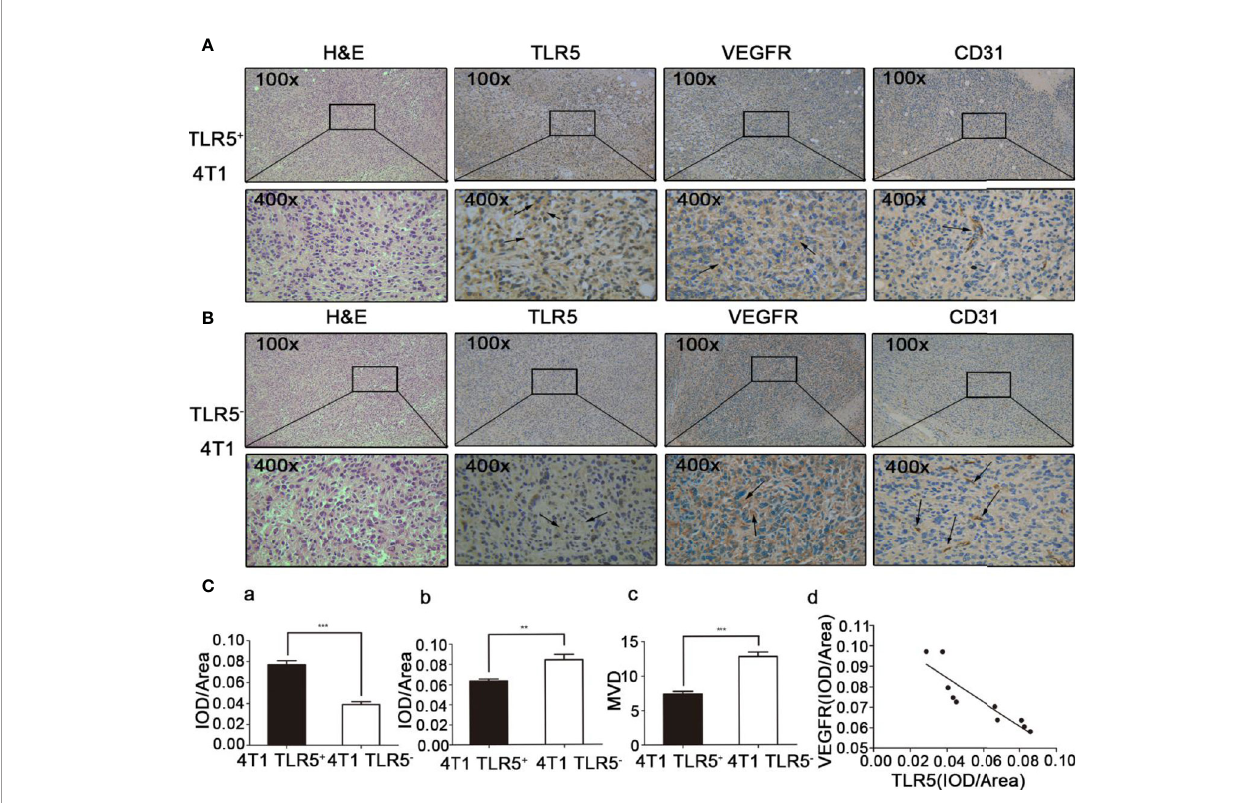
FIGURE 6 | H&E staining and immunohistochemistry staining of ex vivo tumor tissue. TLR5 + 4T1 tumors, representative H&E staining, and TLR5/VEGFR/CD31 immunohistochemistry staining at 200× and 400× magni fi cation (A) . TLR5 − tumors, representative H&E staining, and TLR5/VEGFR/CD31 immunohistochemistry staining at 200× and 400× magni fi cation (B) . Statistical analysis of TLR5 detected by IOD/area ratio (C a ) ; VEGFR detected by IOD/area ratio (C b ) ; MVD count in CD31 labeled tumor (C c ) ; and correlation analysis of TLR5 and VEGFR (C d ) . **P < 0.01, ***P <